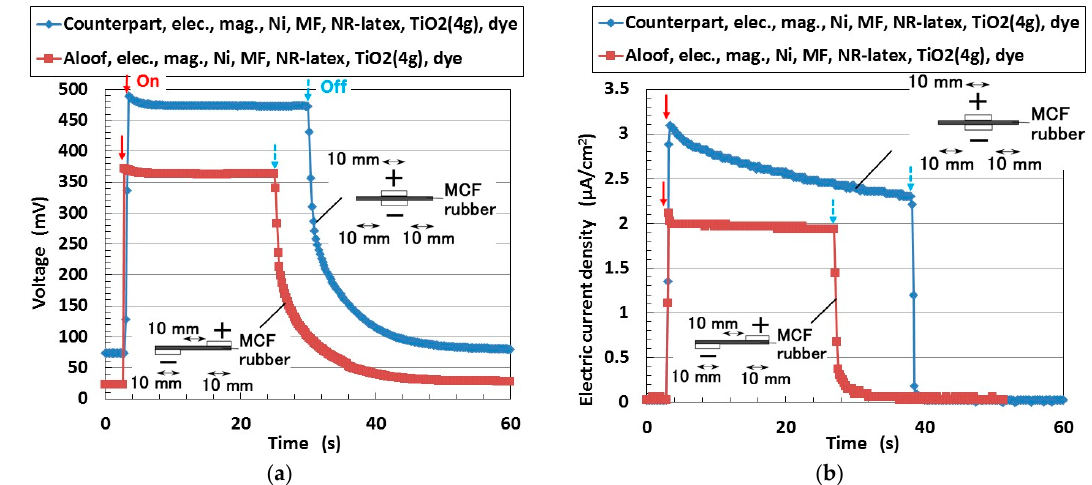
Figure 16. Changes in voltage and electric current density under ultraviolet light on (indicated by red arrow) and off (indicated by blue arrow) by electrode location for wet-type MCF rubber solar cell electrolytically polymerized under a magnetic field with Ruthenium complexes dye and electrolyte KI + I 2 : ( a ) voltage; ( b ) electric current density.